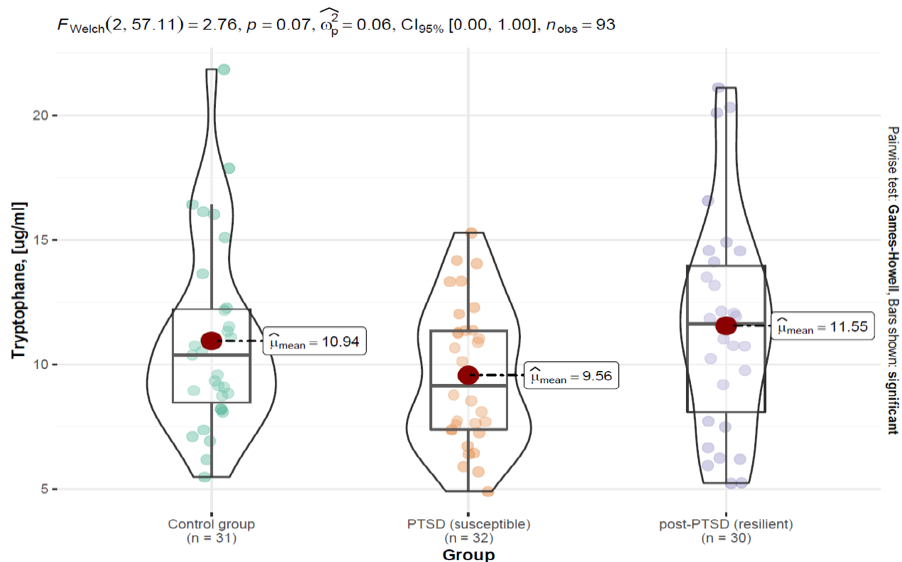
Figure 2. Distribution of the tryptophan variable by patient groups in the form of a violin plot, including statistical tests and differences between the groups.